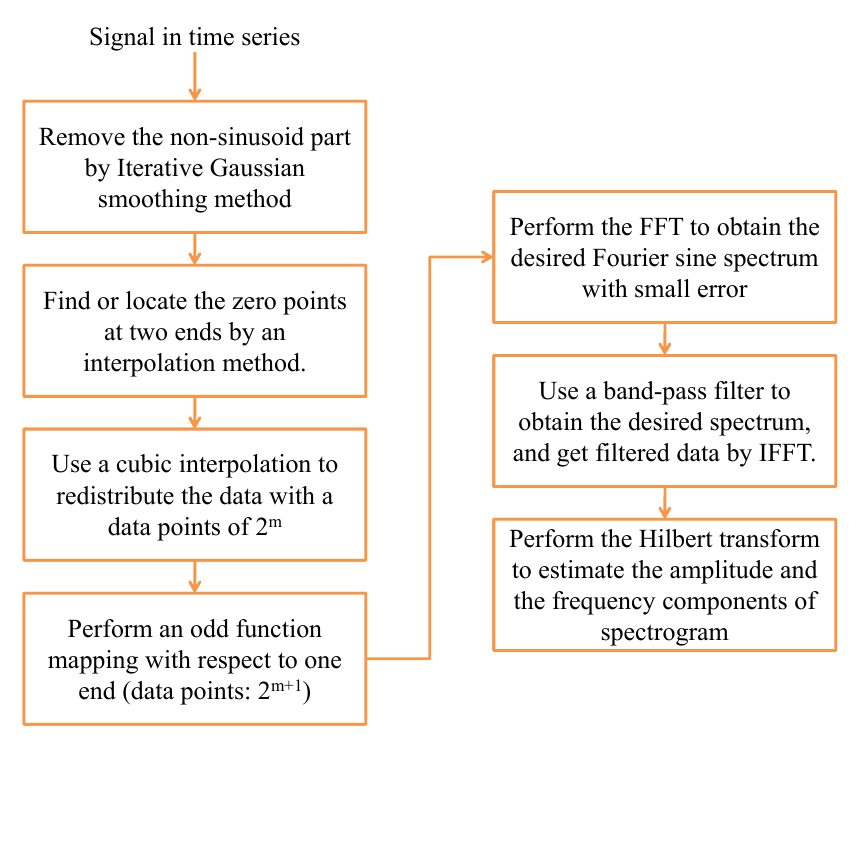
Figure 1. The procedure of generating a spectrogram with small error using the Fourier sine spectrum